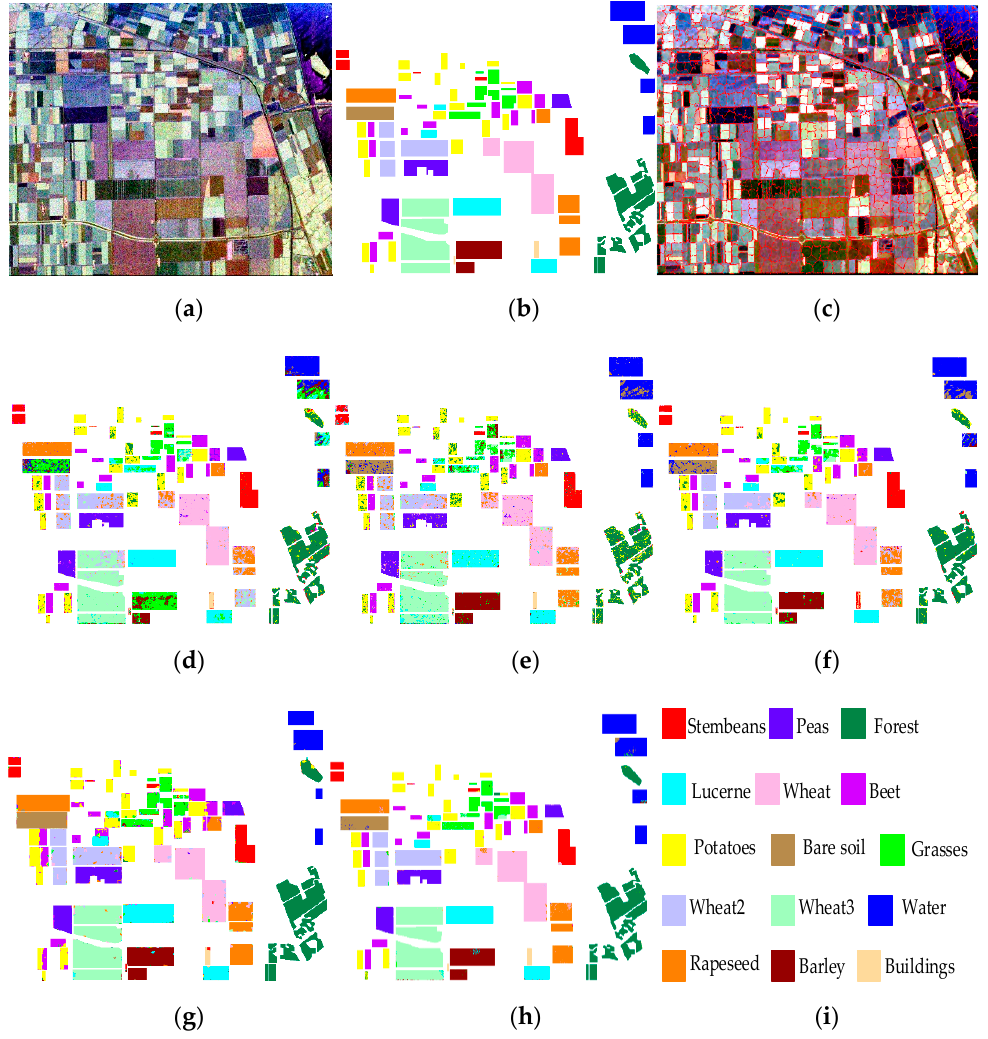
Figure 3. Results of different methods on Flevoland. (a) Pauli RGB image. (b) Ground truth. (c) Superpixel-based segmentation results ( n = 2000). (d) Wishart. (e) SVM. (f) SSAE-LS. (g)SRDNN-MD. (h) Proposed. (i) Color code.